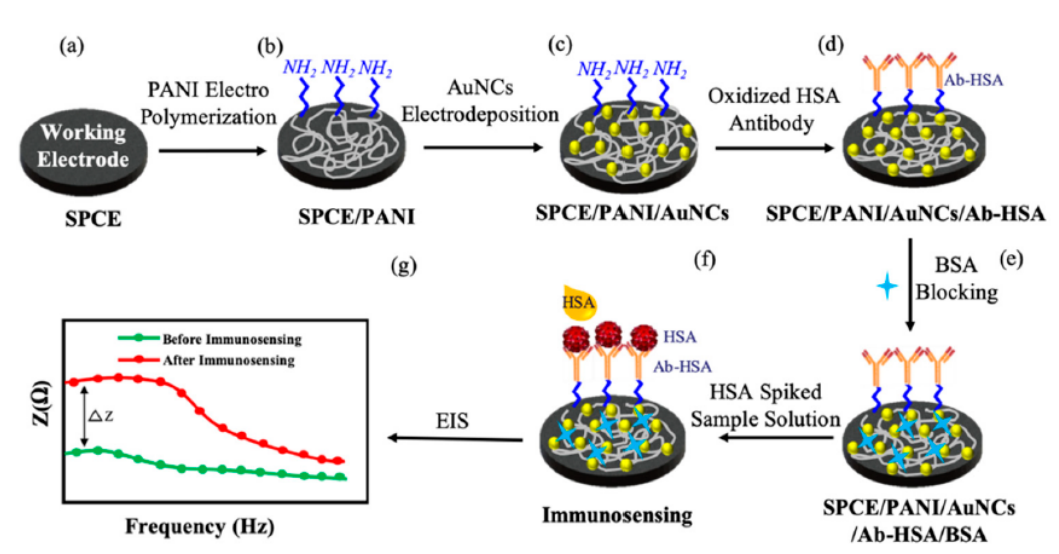
Figure 5. Schematic representation of the protocol for surface modification and immunosensing. SPCE: Screen-printed carbon electrodes, PANI: polyailine, AuNCs: gold nanocrystals, HSA: human serum